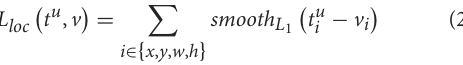
TABLE 2 The list of hardware and software equipment.